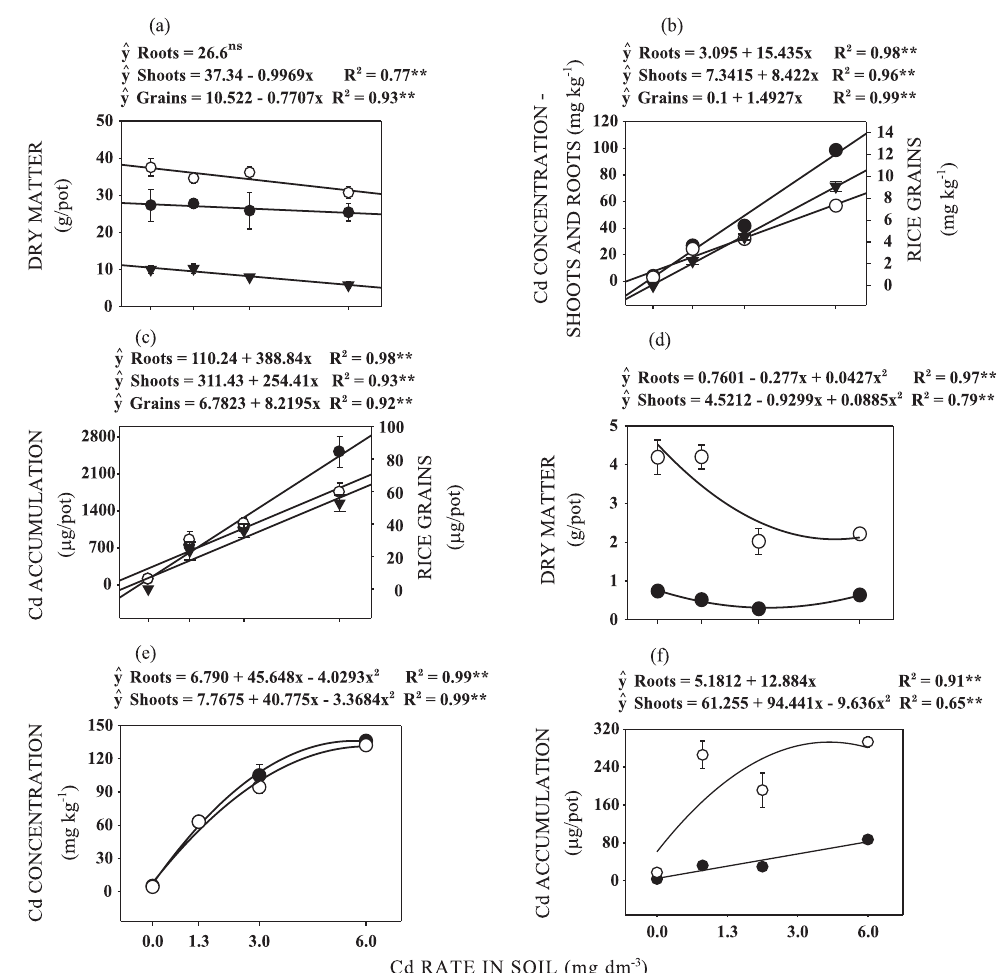
Figure 1. Dry matter yields of rice (a) and lettuce (d); Cd concentration in rice (b) and in lettuce (e) and Cd accumulation in rice (c) and lettuce (f) grown with Cd rates applied to the soil. ( ) roots; ( ) shoots; ( ) rice grain. ( ns ) and (**) non-significant and significant at p < 0.01,